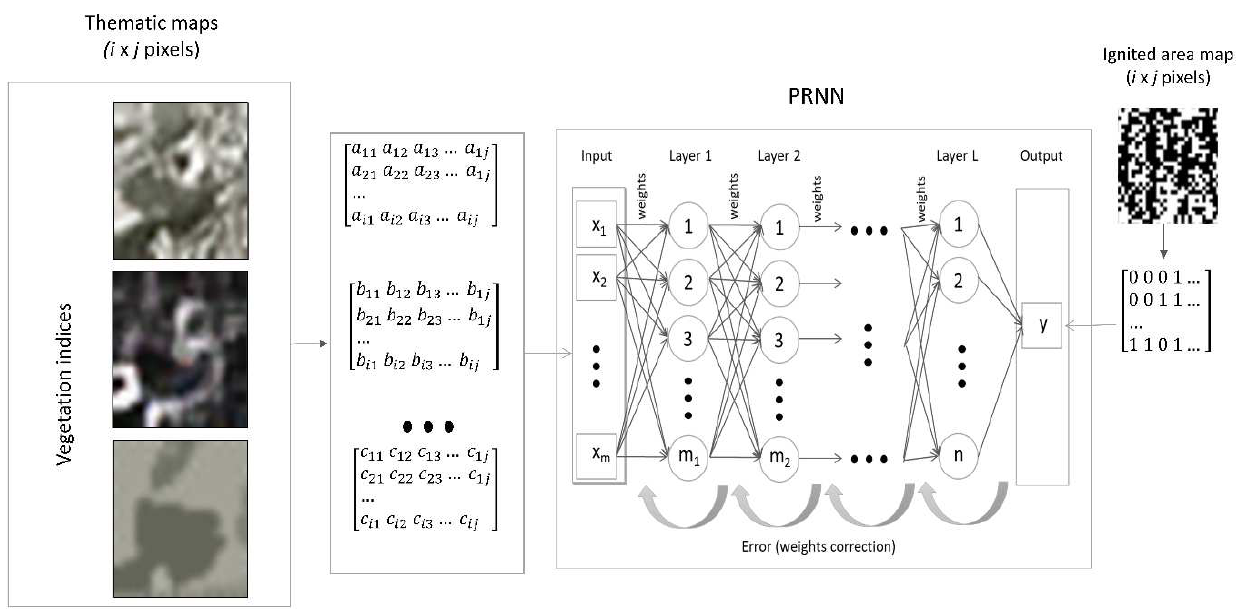
Figure 2. PRNN for estimating the relationship between temporal VIs behavior and probability of ignition. Table 1. VIs considered in the